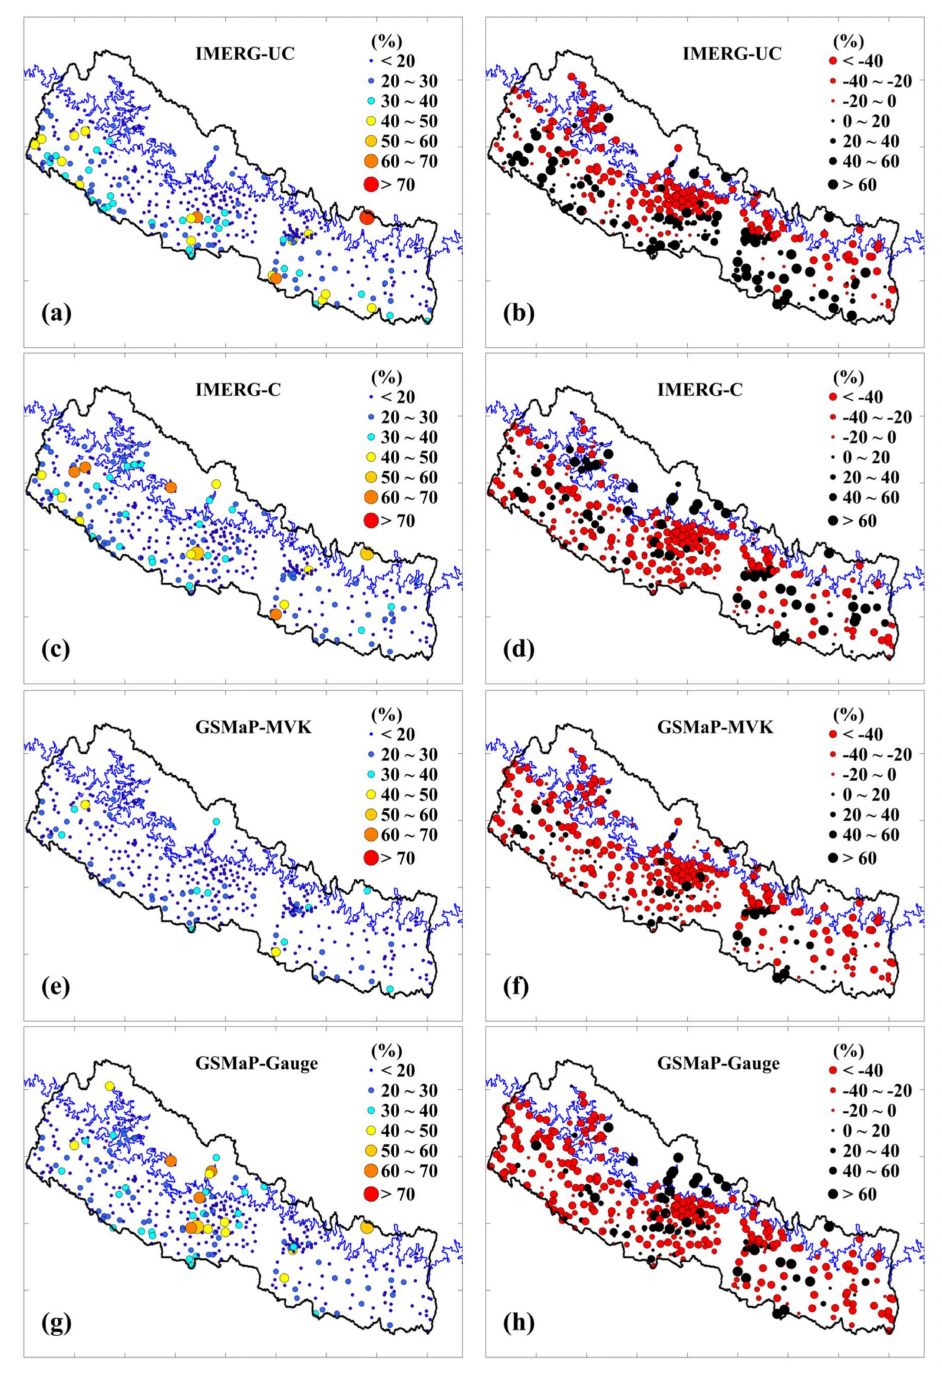
Figure 7. Spatial distribution of the daily precipitation 95th percentile from 2014 to 2015 in the four SBP datasets. Figure ( a , c , e , g ) shows the accurately detected extreme precipitation events in (%), ( b , d , f , h ) bias in extreme precipitation events for each station. The black and blue lines denotes the national boundary of the country and 3000 masl elevation contour,